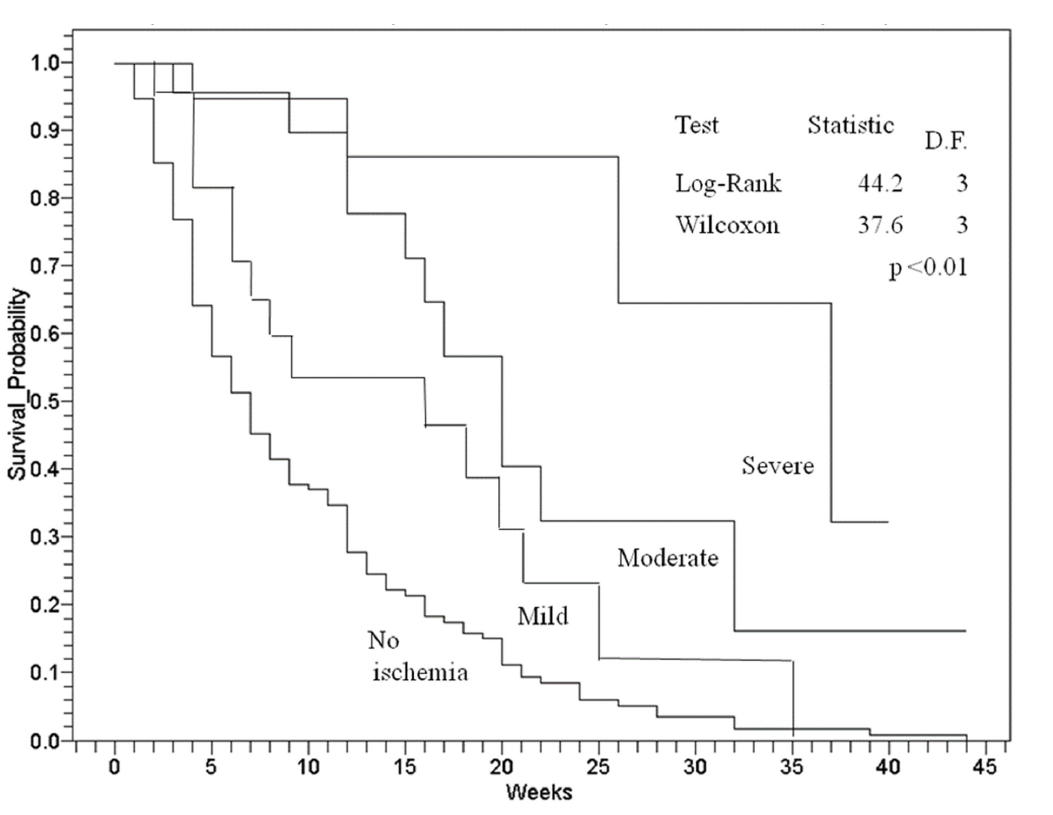
Figure 1. Kaplan–Meier survival probability analysis for wound healing failure by weeks according to the severity of ischaemia.